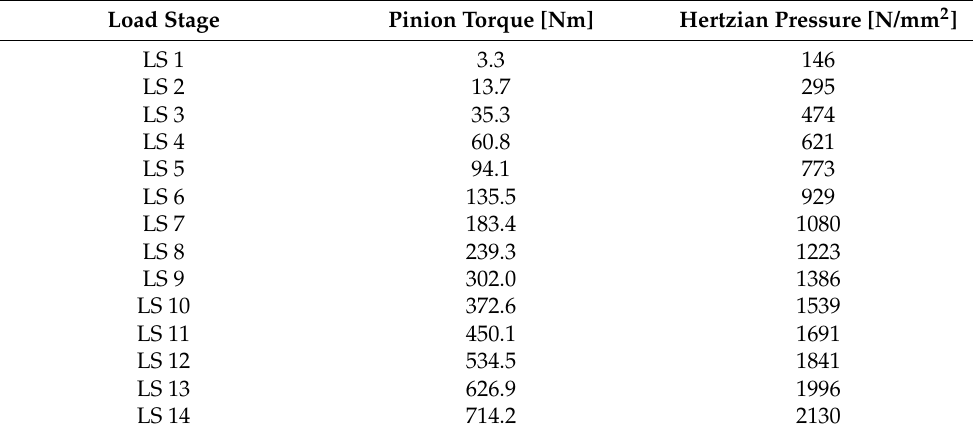
Table 1. FZG load